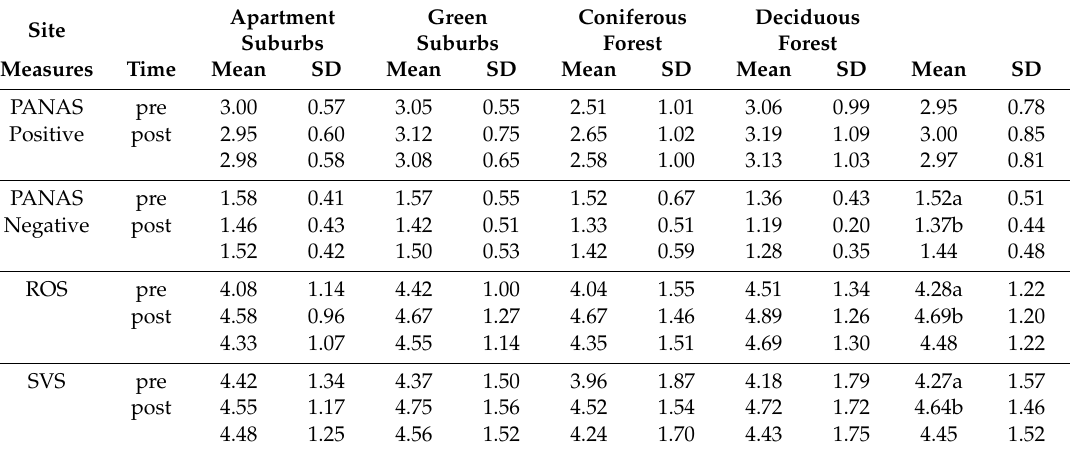
Table 4. Means and SD of psychological measures in four places during the experiment (for PANAS, ROS and SVS scales).